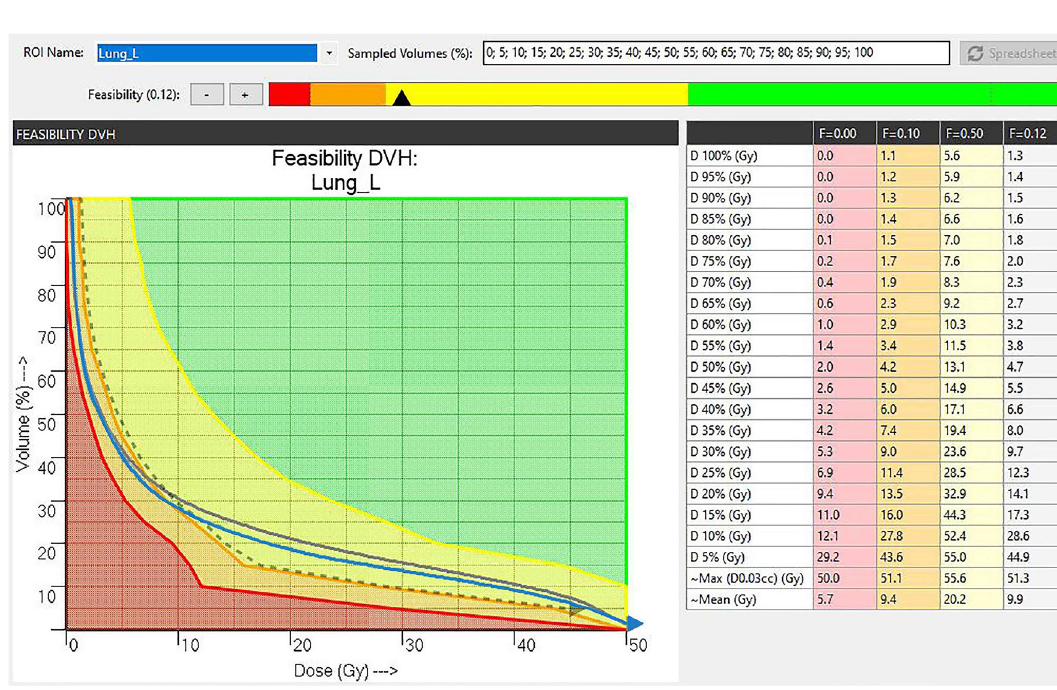
Figure 2. The FDVH diagram of ipsilateral lung. The green region was considered dosimetrically easy to achieve, yellow was more challenging, orange is difficult, and the red region indicates an region which cannot be achieved. The gray line represents the FDVH curve of the affected lung of NP group, while the dashed line represents the FDVH curve of the affected lung of RP group when F is 0.12. The V20 in the yellow region of great concern in RP group is significantly lower than that of NP